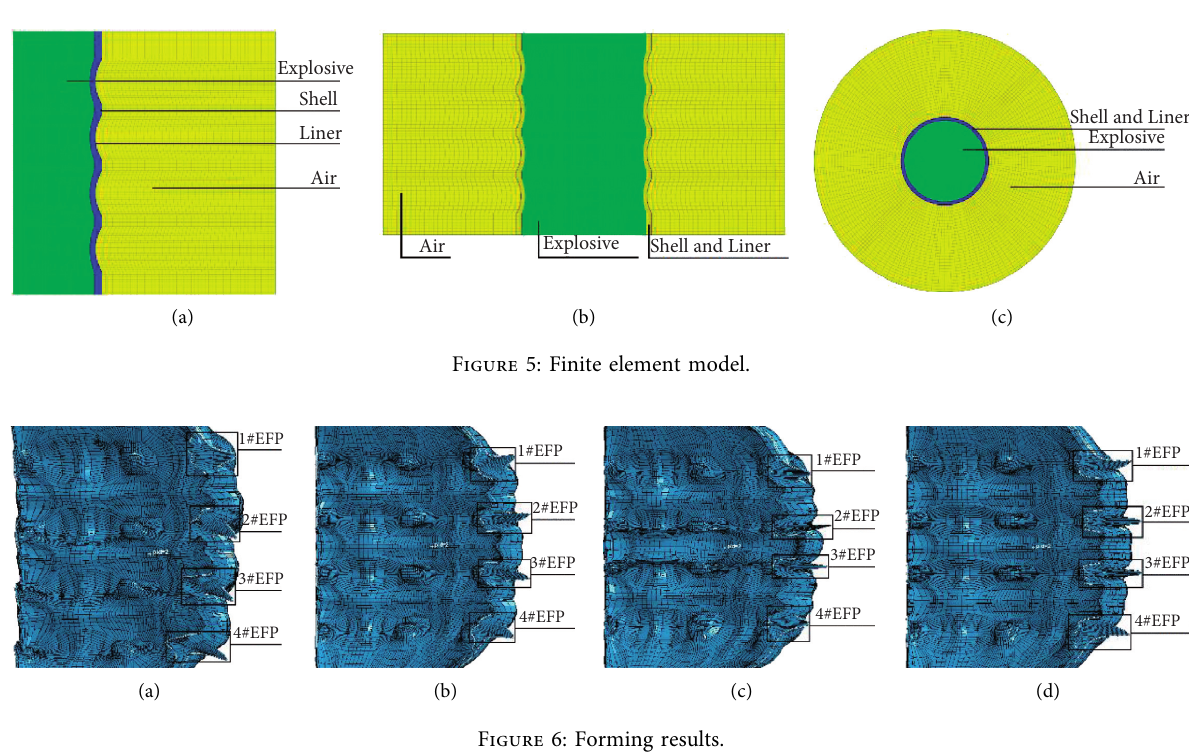
Figure 4: Structure diagram of double-column eccentric initiation mode.